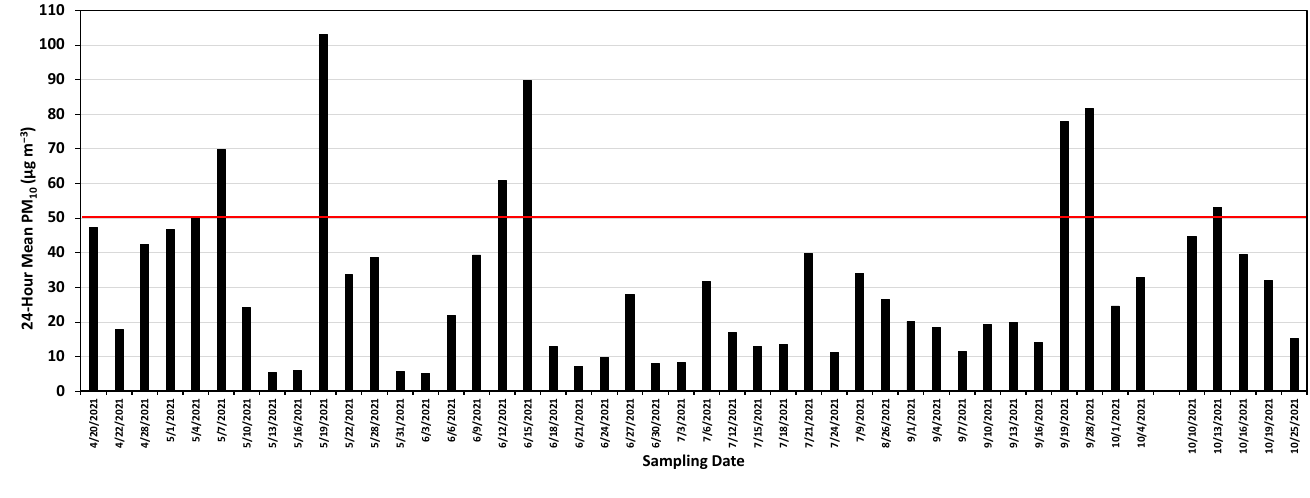
Figure 3. The validated mean 24 h PM 10 ( µ g m − 3 ) concentration for the days sampled between April and October 2021. Concentration of PM 10 was determined from gravimetric analysis of the Teflon-membrane filter. The horizontal line represents the state mean 24 h PM 10 standard of 50 µ g m − 3 . Table 1. BAM vs. gravimetric PM 10 concentration comparisons, linear regressions.